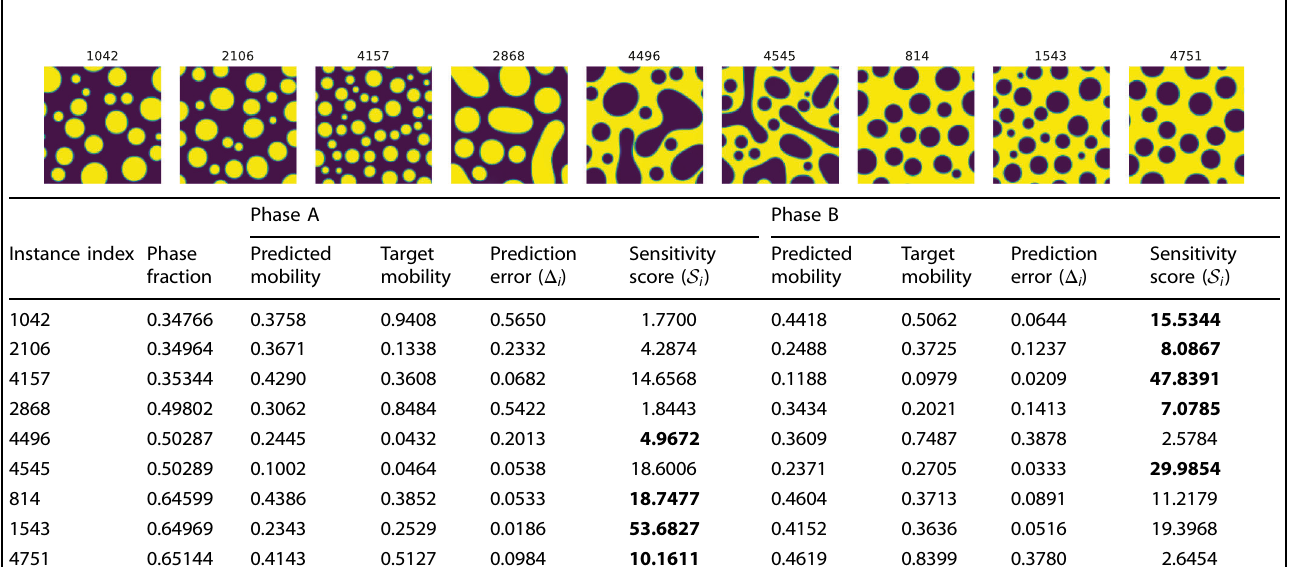
Table 1. Prediction of mobility parameters in the case of the spinodal decomposition problem.